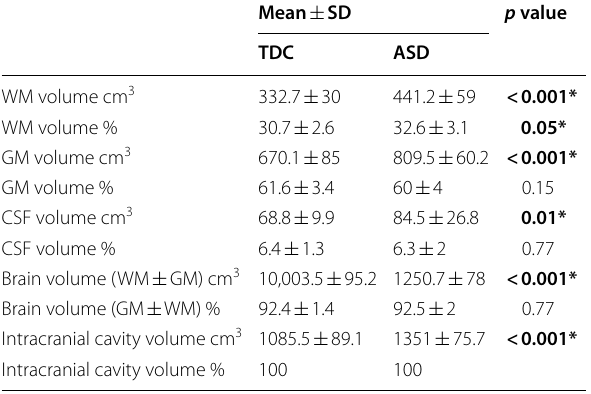
Table 4 Comparing mean volumes of different white matter areas between TDC and ASD groups